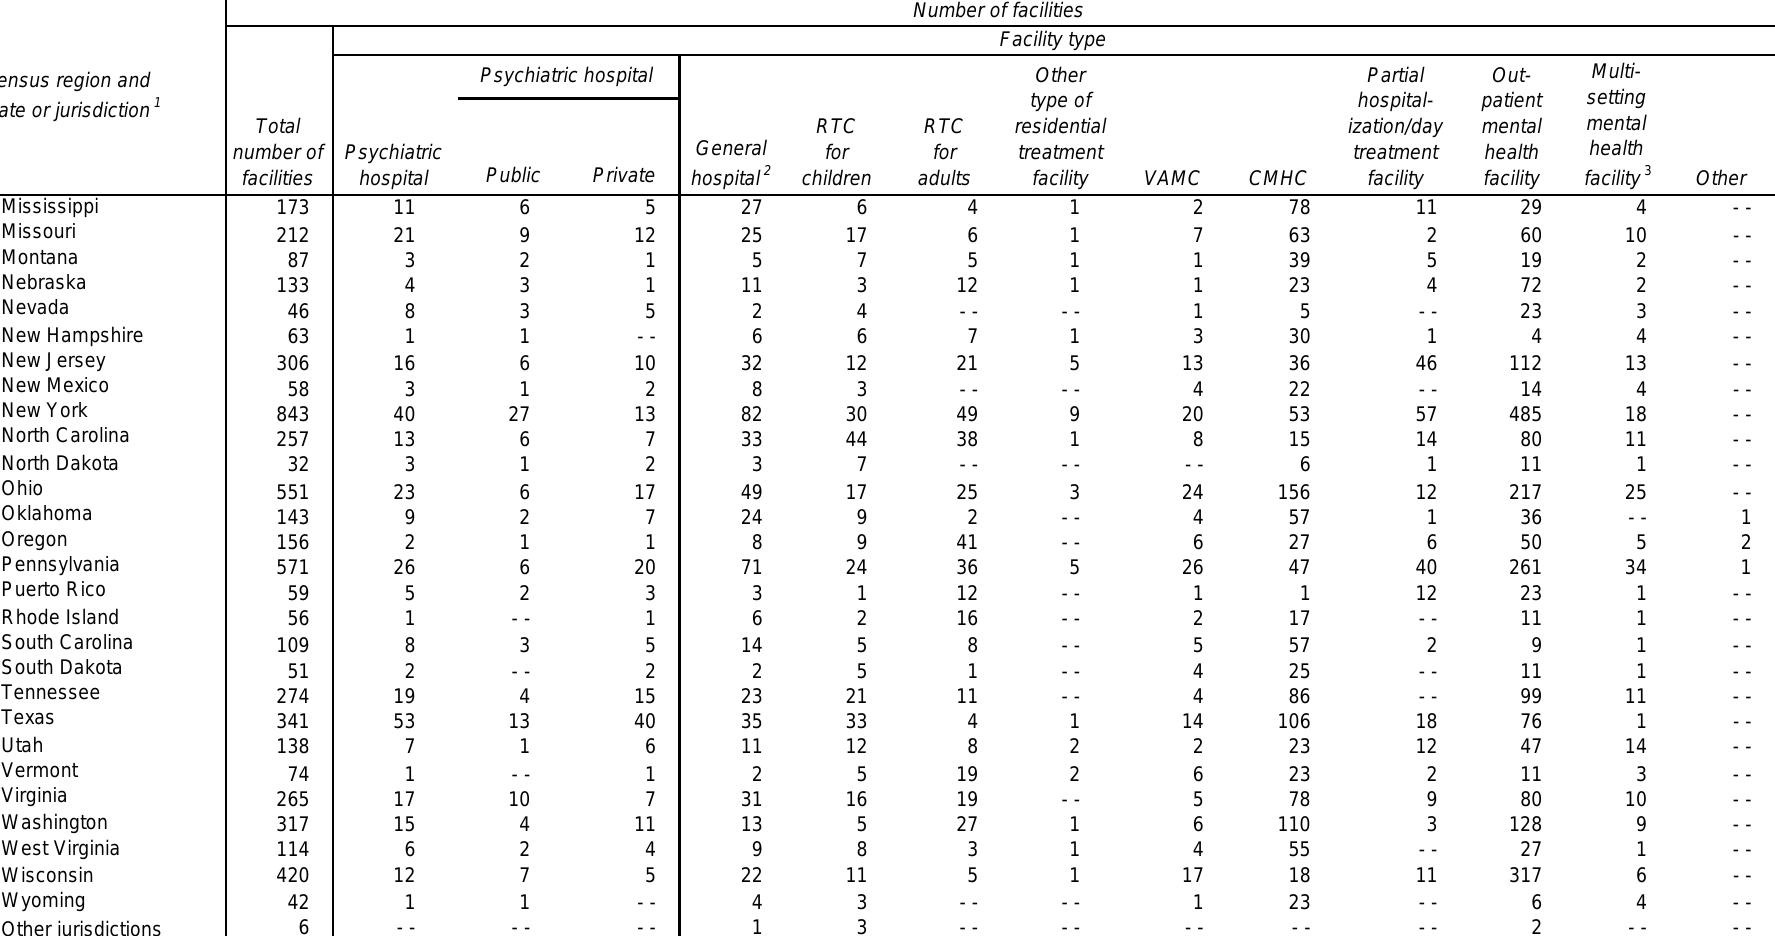
Table 3.1a. Mental health treatment facilities, by facility type, Census region, and state or jurisdiction: Number, 2017